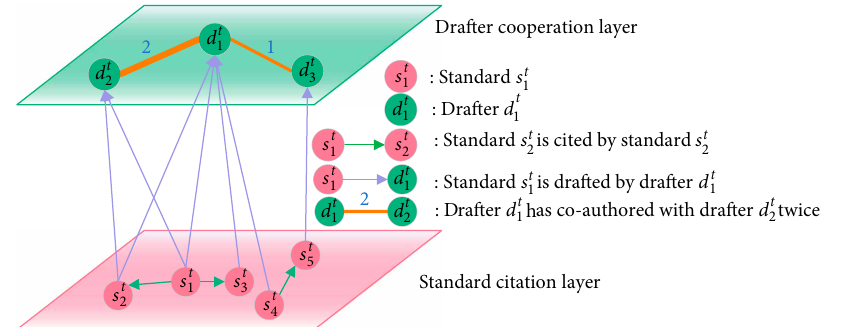
Figure 1: An illustration of dynamic standards network at time